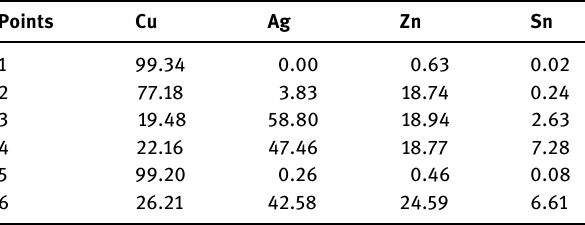
Table 2: Mass phase energy spectral data of the brazed joints of the Ag - based composite core fi ller metal in Figure 3